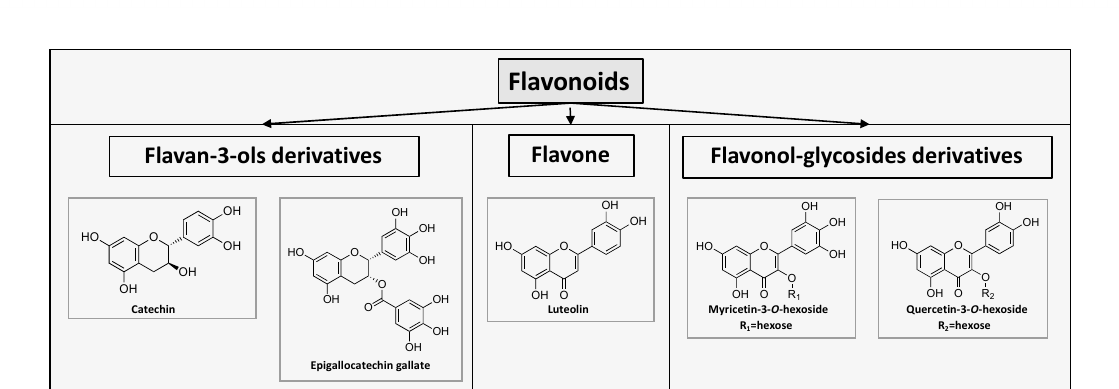
Figure 3. Main phenolic compounds found in carob products.